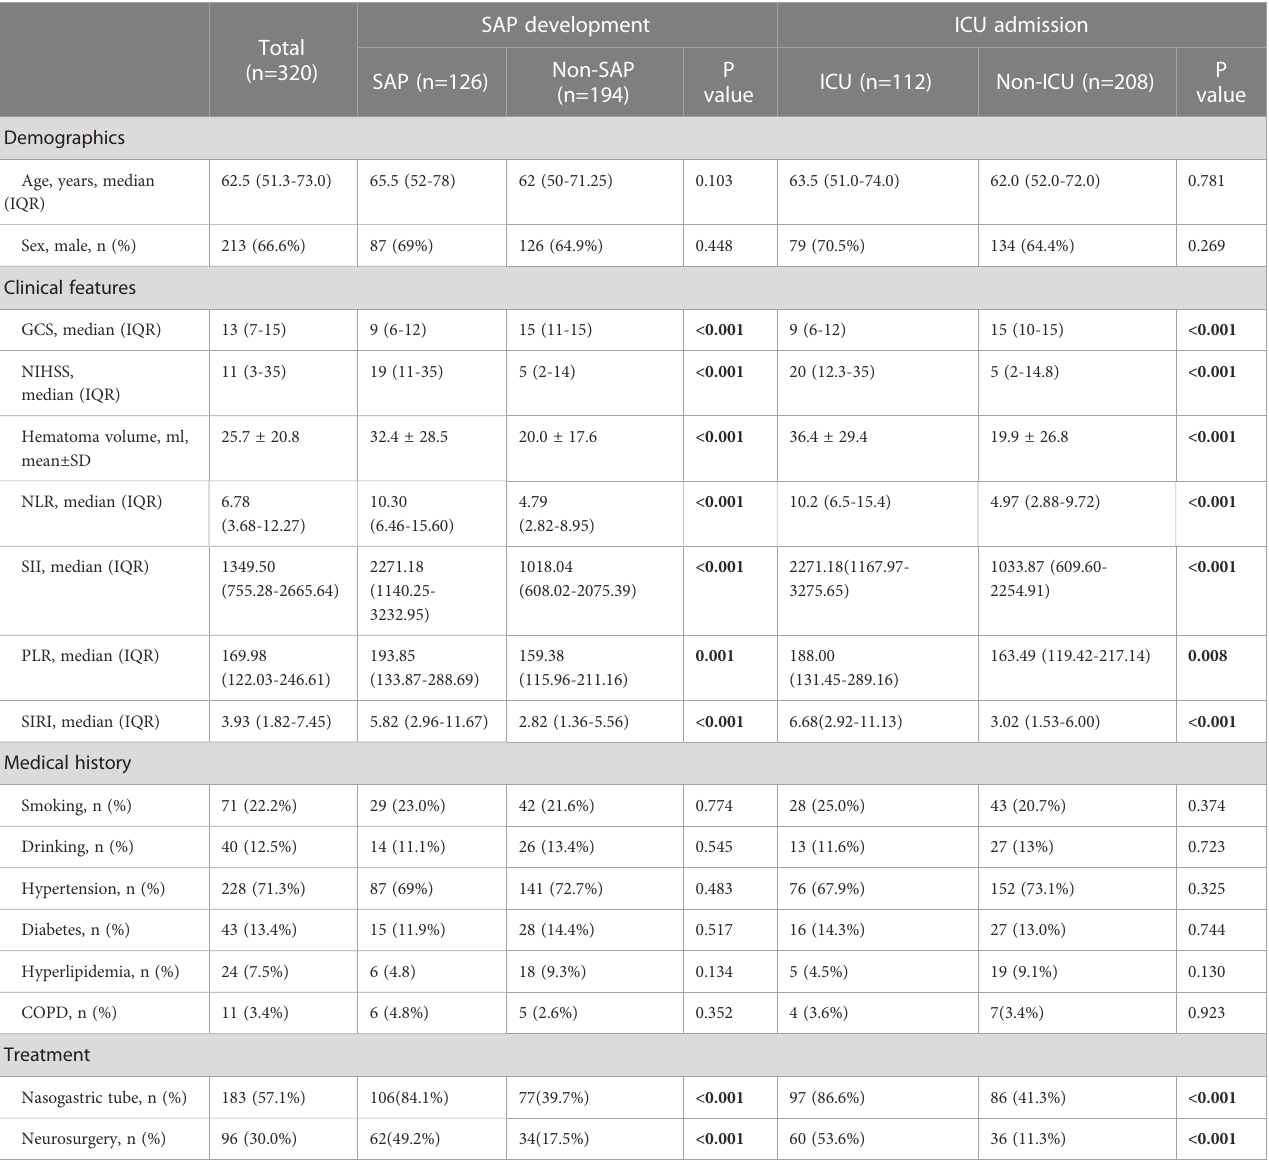
TABLE 1 Baseline characteristics of the 320 patients with